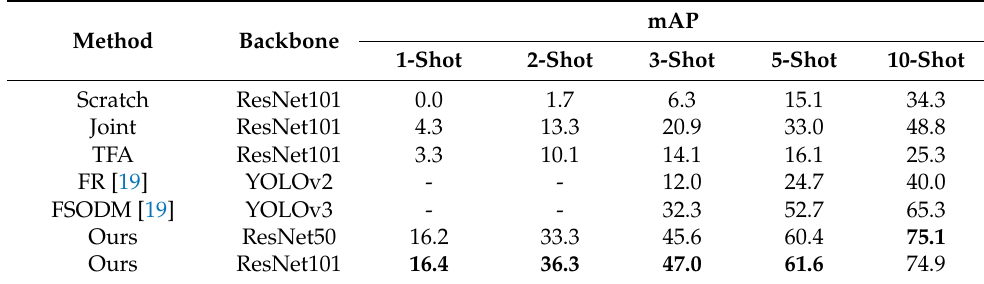
Table 1. Few-shot detection performance on novel classes of the NWPU VHR-10